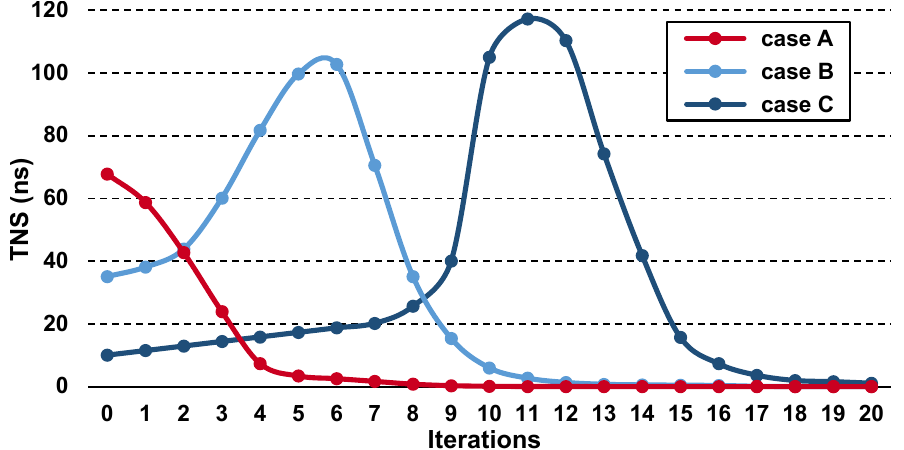
Figure 4. Evolution of TNS on each iteration of a LR-based gate sizer for three cases of the same design. In case A, design is not optimized. In cases B and C, it is partially optimized, thus exhibiting initially less